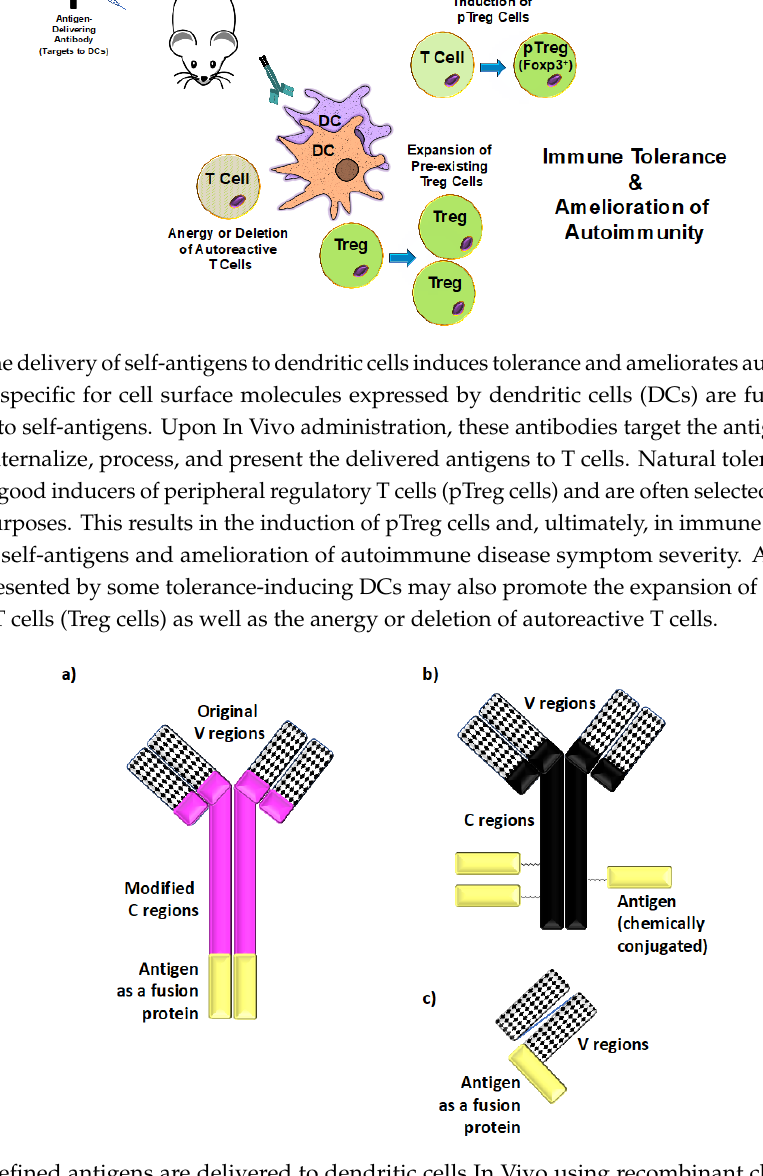
Figure 2. Defined antigens are delivered to dendritic cells in vivo using recombinant chimeric and other types of antibodies. ( a ) Recombinant chimeric antibodies, which deliver defined peptide or protein antigens (shown in yellow in panels (a–c)) to specific dendritic cell (DC) cell surface molecules, are comprised of the variable (V) regions derived from monoclonal antibodies specific for cell surface molecules expressed on DCs and the species-specific heavy and light constant (C) regions derived from separate immunoglobulins. The peptide antigen of choice is genetically fused to the C regions. This recombinant chimeric antibody design enhances the targeting specificity in vivo by minimizing non-specific binding to Fc receptors, and it also helps to avoid stoichiometric differences in the amounts of antigenic materials present in such reagents. ( b ) Antibody–antigen conjugates are comprised of antigenic proteins chemically conjugated to native antibodies specific for cell surface molecules expressed on DCs. Such conjugates have been successfully used to deliver defined antigens to DCs, although they may lack some of the targeting specificity-enhancing modifications found in recombinant chimeric antibody designs. ( c ) Single-chain fragment variable (scFv) constructs provide yet another means of delivering antigen In Vivo. scFv constructs are comprised of a linker joining the corresponding V regions genetically fused to the antigen for